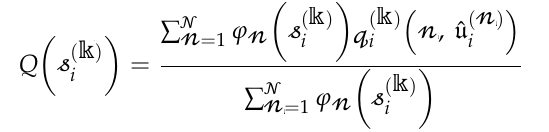
Figure 2. Membership function of fuzzy input of the 𝑖 (cid:3047)(cid:3035) subsystem.